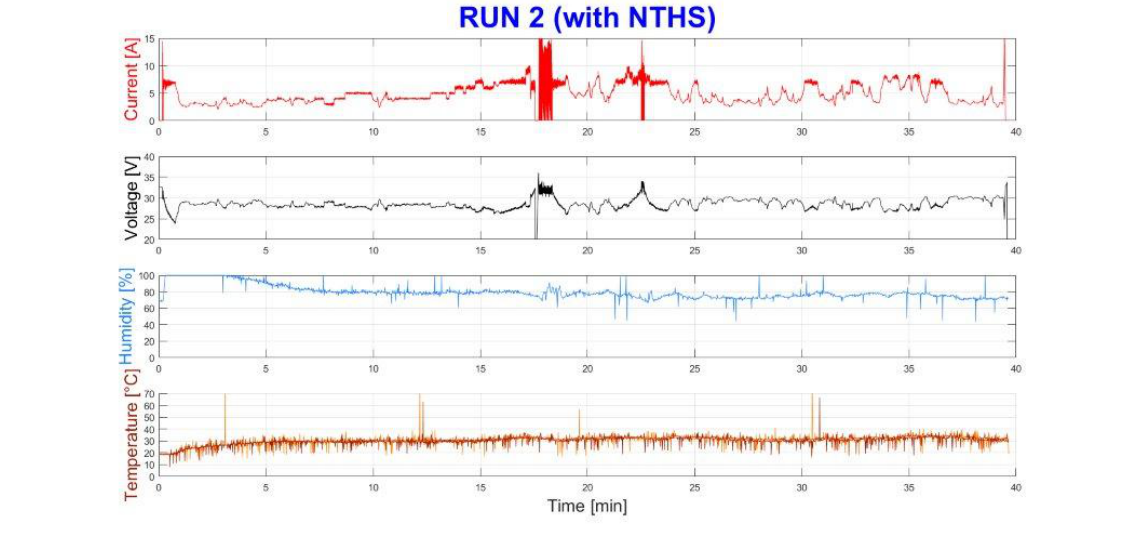
Figure 12. Results during the Run 2 with